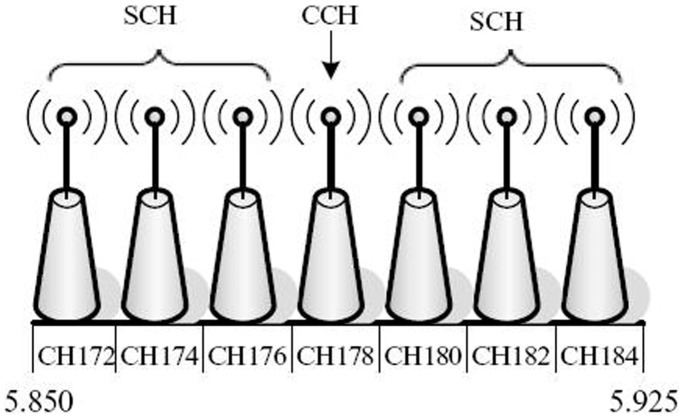
IEEE802.11p channel distribution [22].